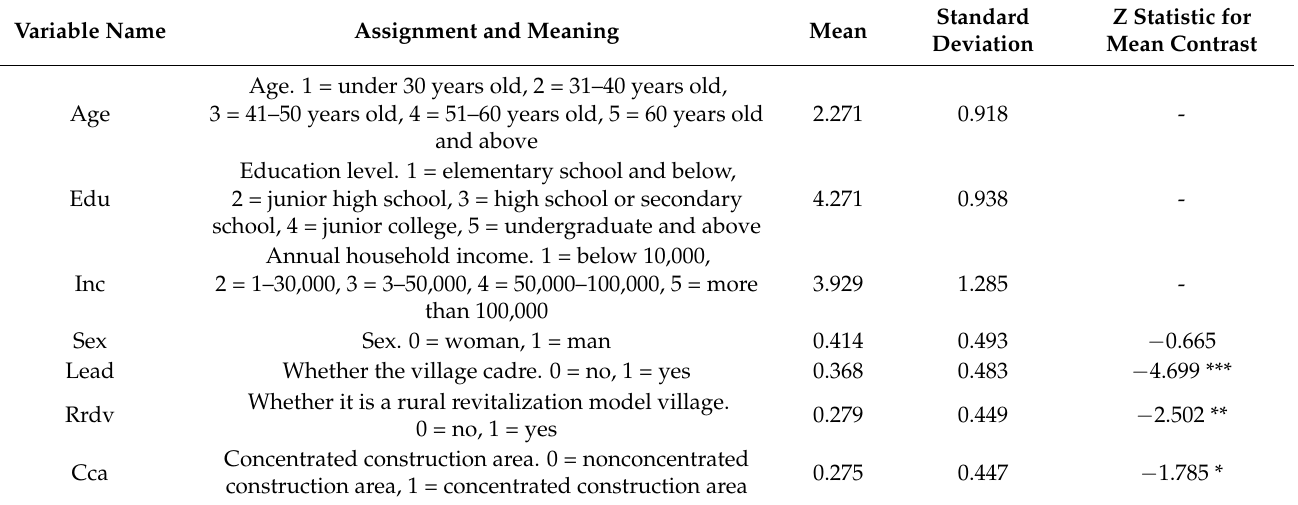
Table 4. Control variable description and mean comparison